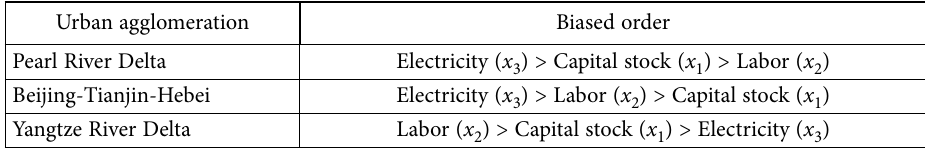
–202 a s b i o f ee g r D e Figure 9. Order of input technological progress factors bias of the three major urban agglomerations 2 Table 6. Order of input technological progress bias of each urban agglomeration Urban